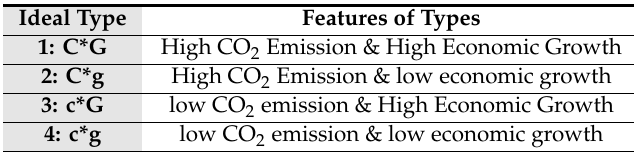
Table 2. The Four Ideal Type Sets.